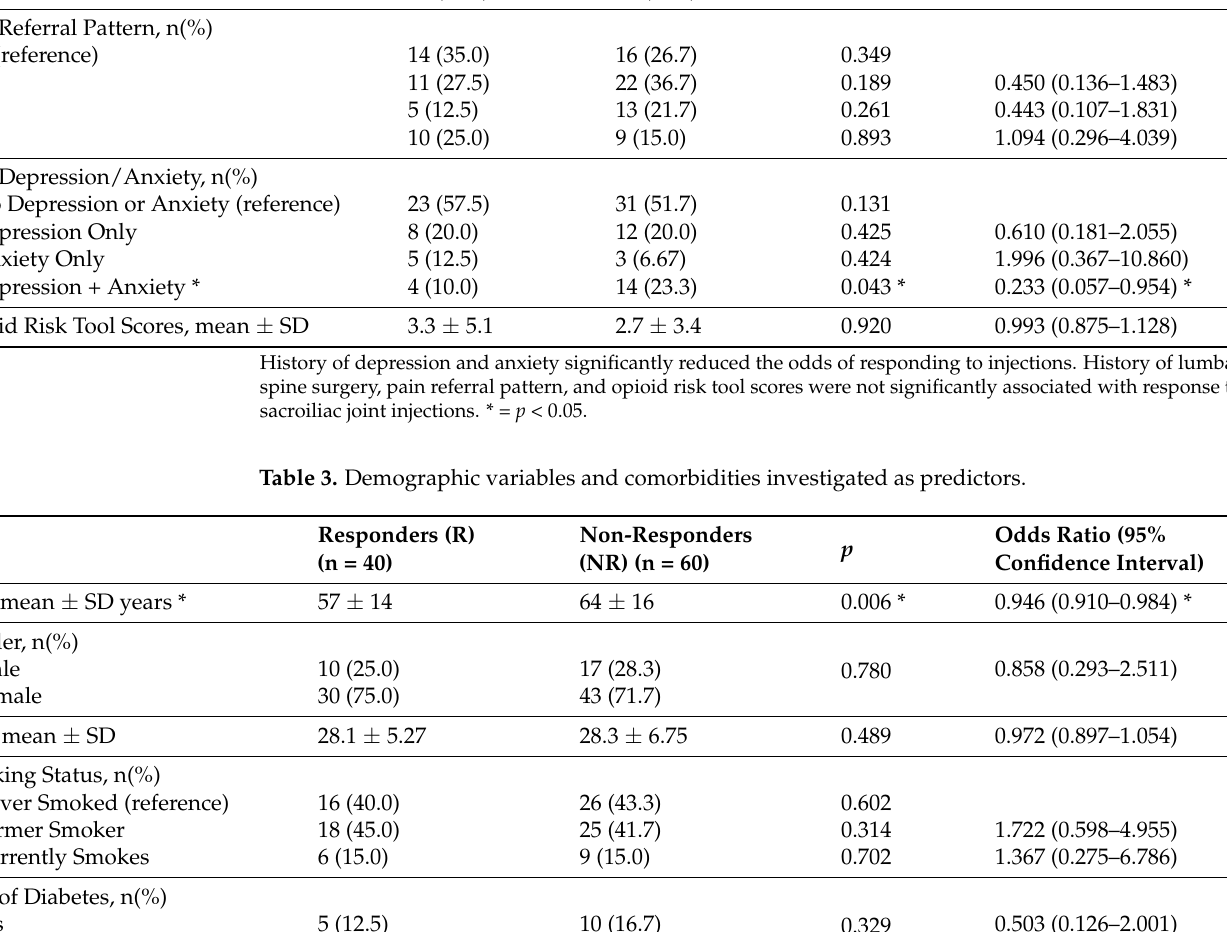
Table 2. Spine specific risk factors investigated as predictors.